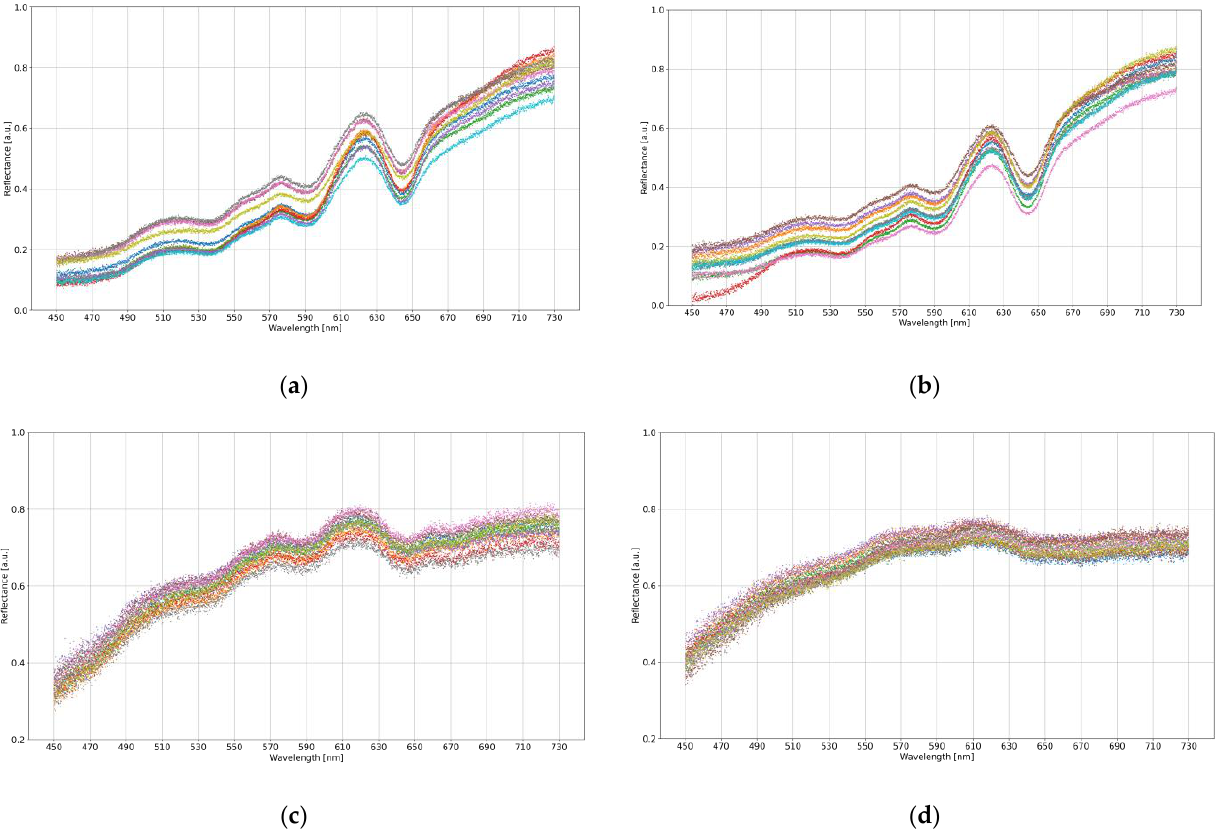
Figure 2. The visualization of an exemplary ten samples taken from each categorical subset: brown eggshell from ( a ) MS-infected and ( b ) healthy hens; white eggshell from ( c ) MS-infected and ( d ) healthy hens. Different colors determine different samples. Table 2. Notation of input data variables and corresponding DPSS wavelengths and their full width at half maximum (FWHM).